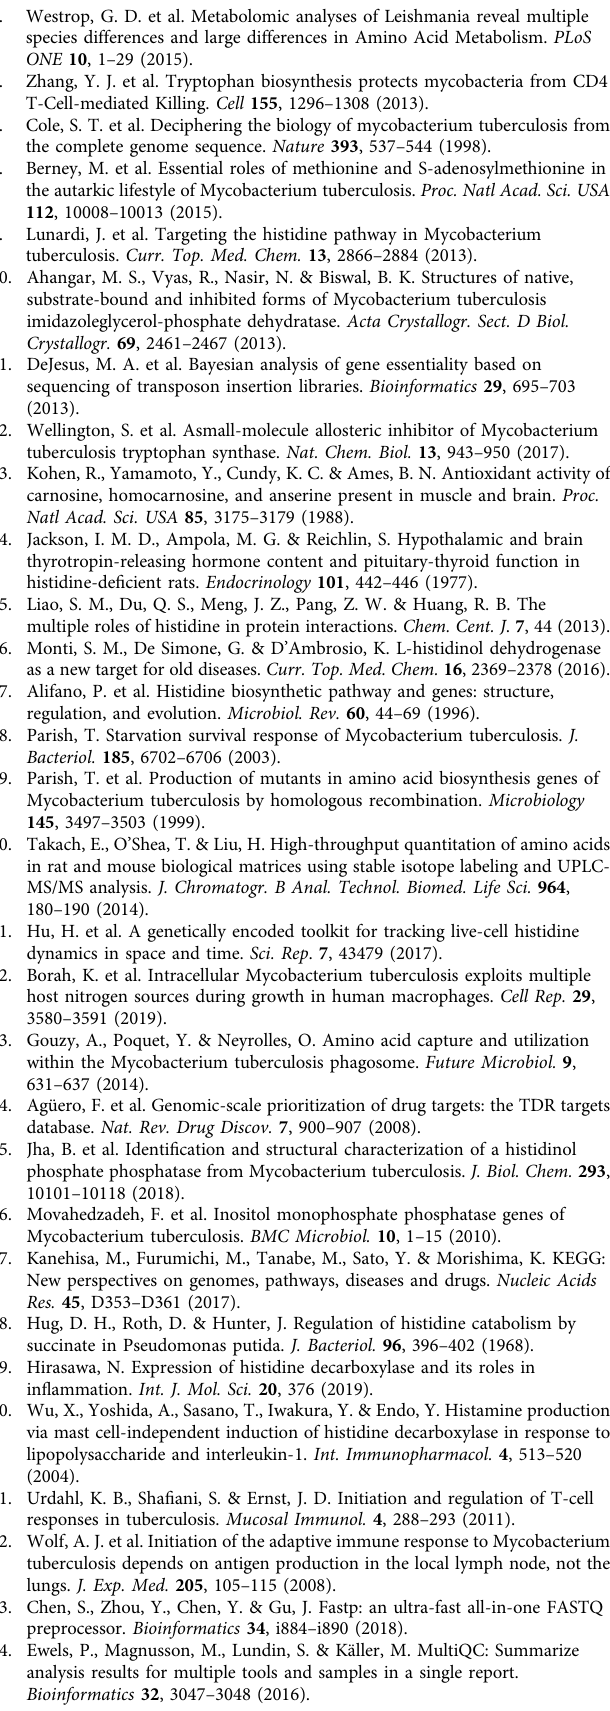
Figs. 22 – 24. All source data underlying the graphs and charts shown in the main and supplementary fi gures are presented in Supplementary Data 4. The raw fi les for the mass spectrometry analyses are available on request from the corresponding